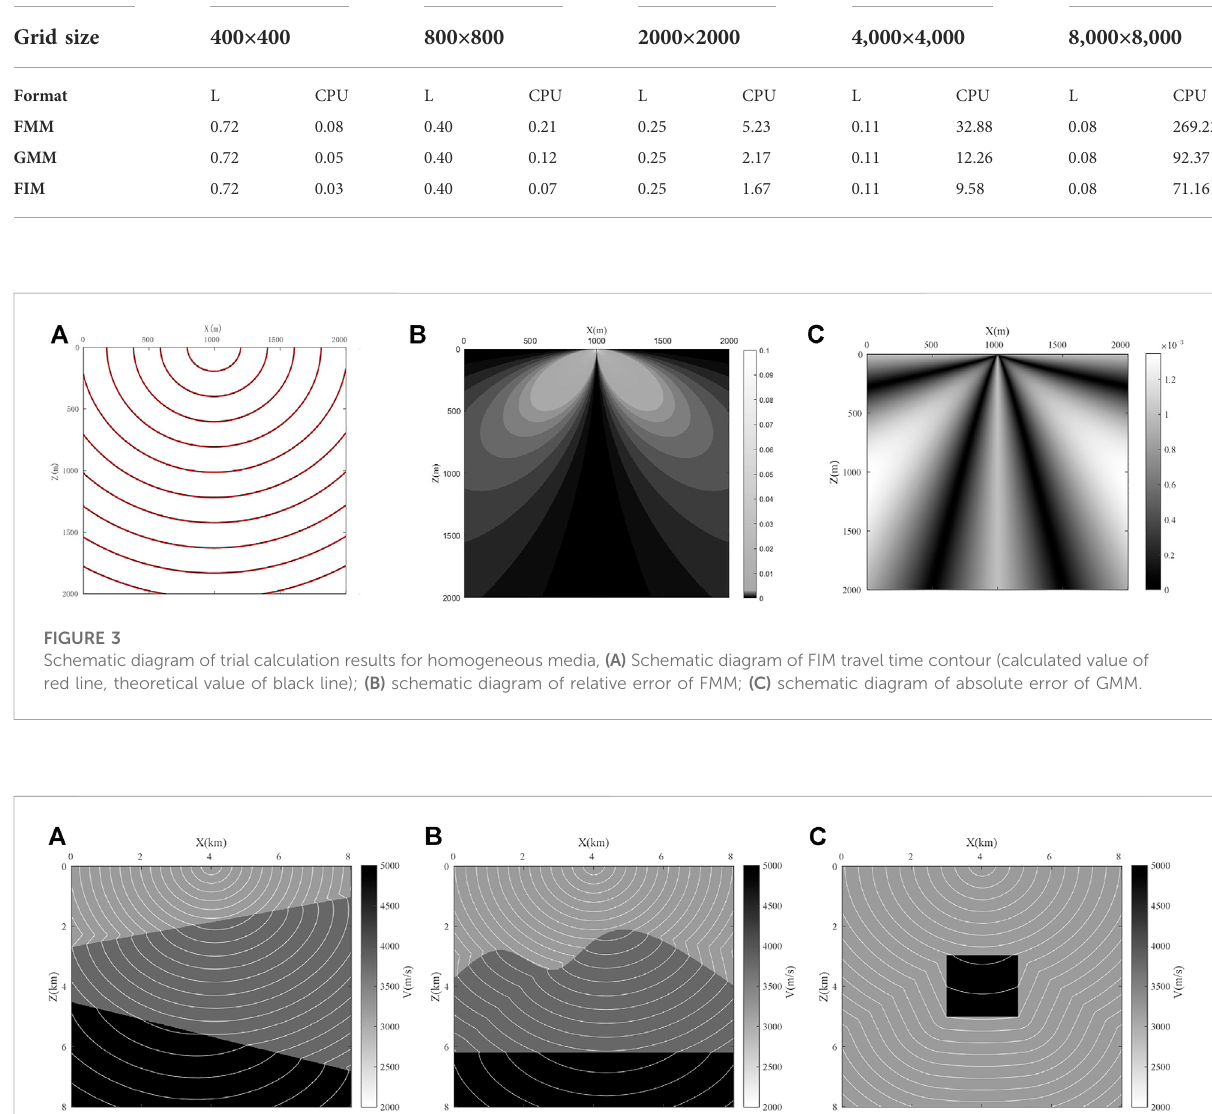
TABLE 1 Analysis of the accuracy and ef fi ciency of the time-travel calculation of the three algorithms. Grid spacing